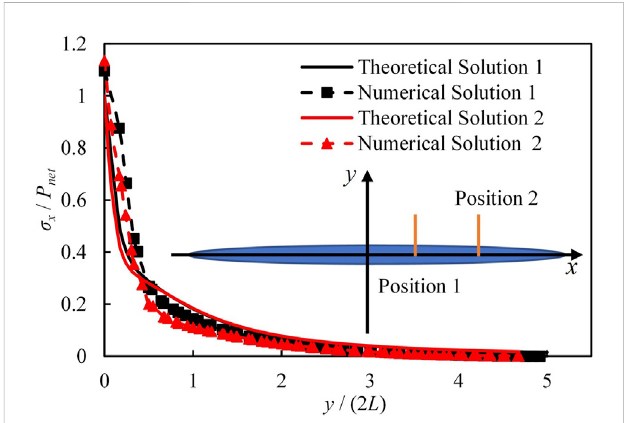
FIGURE 4 Comparison ofthenumericalandtheoreticalsolutionsofthestress distribution along two lines vertical to the